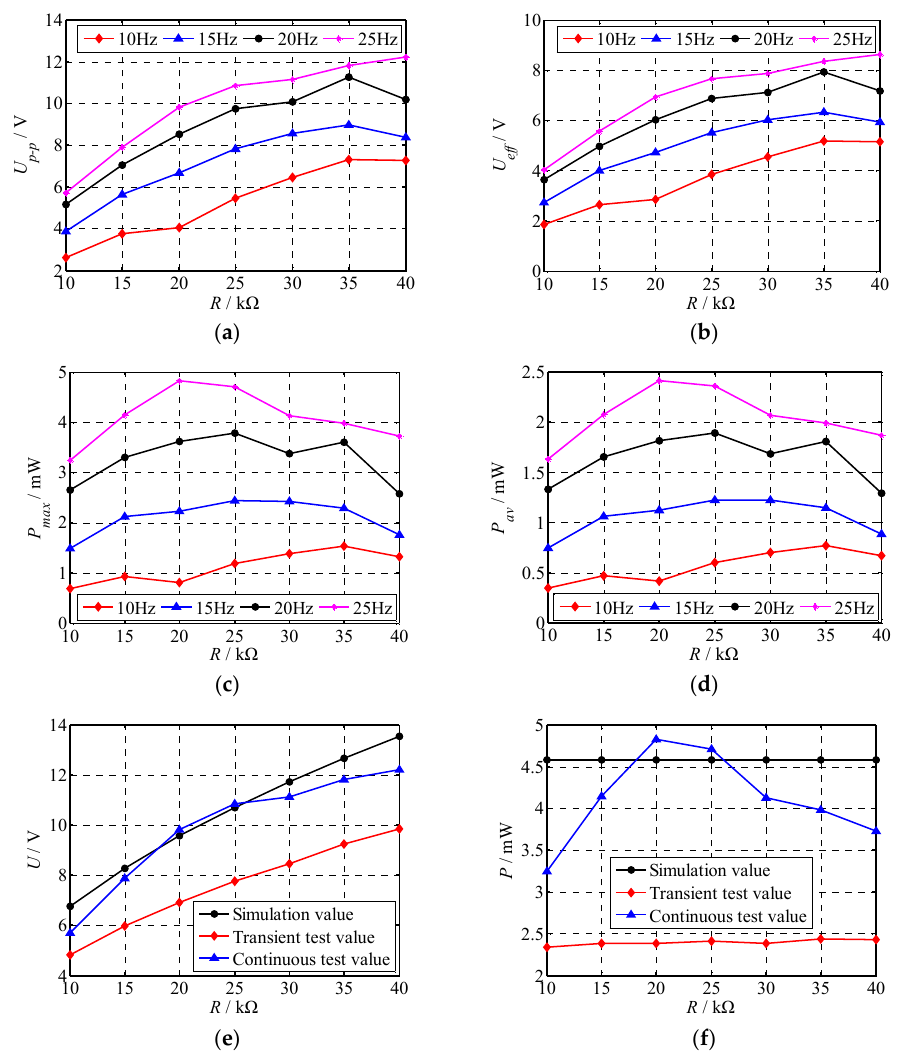
Figure 12. The output voltage and power vary with the load resistance. ( a ) Maximum voltage; ( b ) effective voltage; ( c ) maximum power; ( d ) average power; ( e ) comparison of experimental and simulated voltages; ( f ) Comparison of experimental and simulated powers.